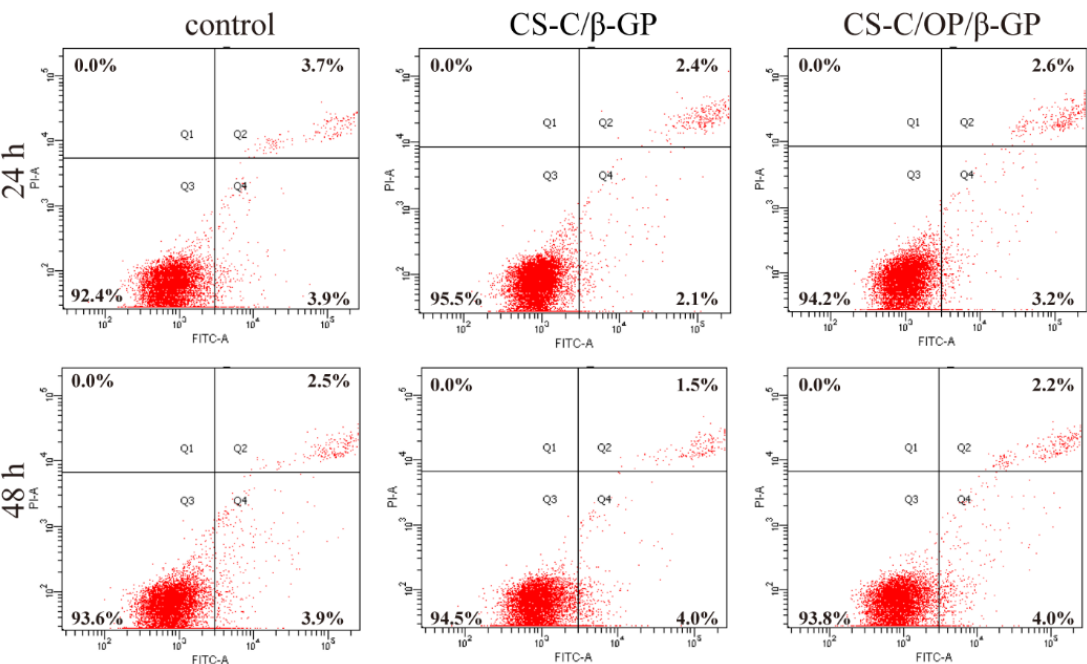
Figure 9. Analysis of L929 cell apoptosis by flow cytometry.